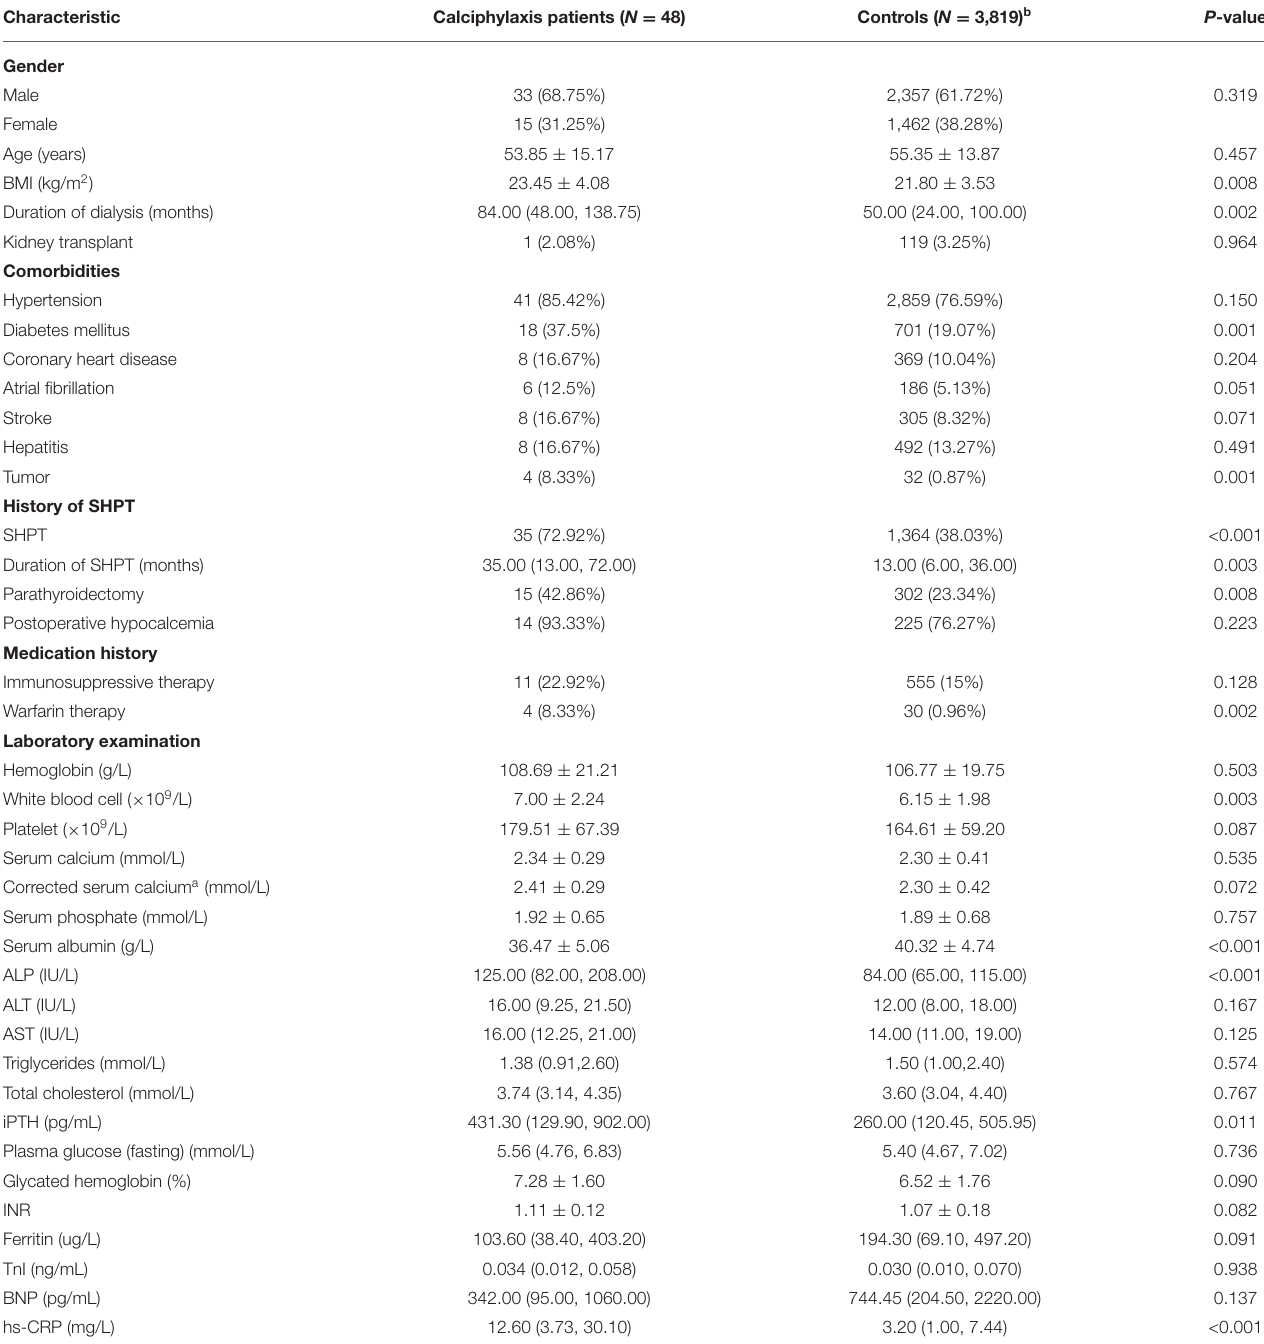
TABLE 3 | Comparison of baseline characteristics between calciphylaxis and non-calciphylaxis hemodialysis patients.